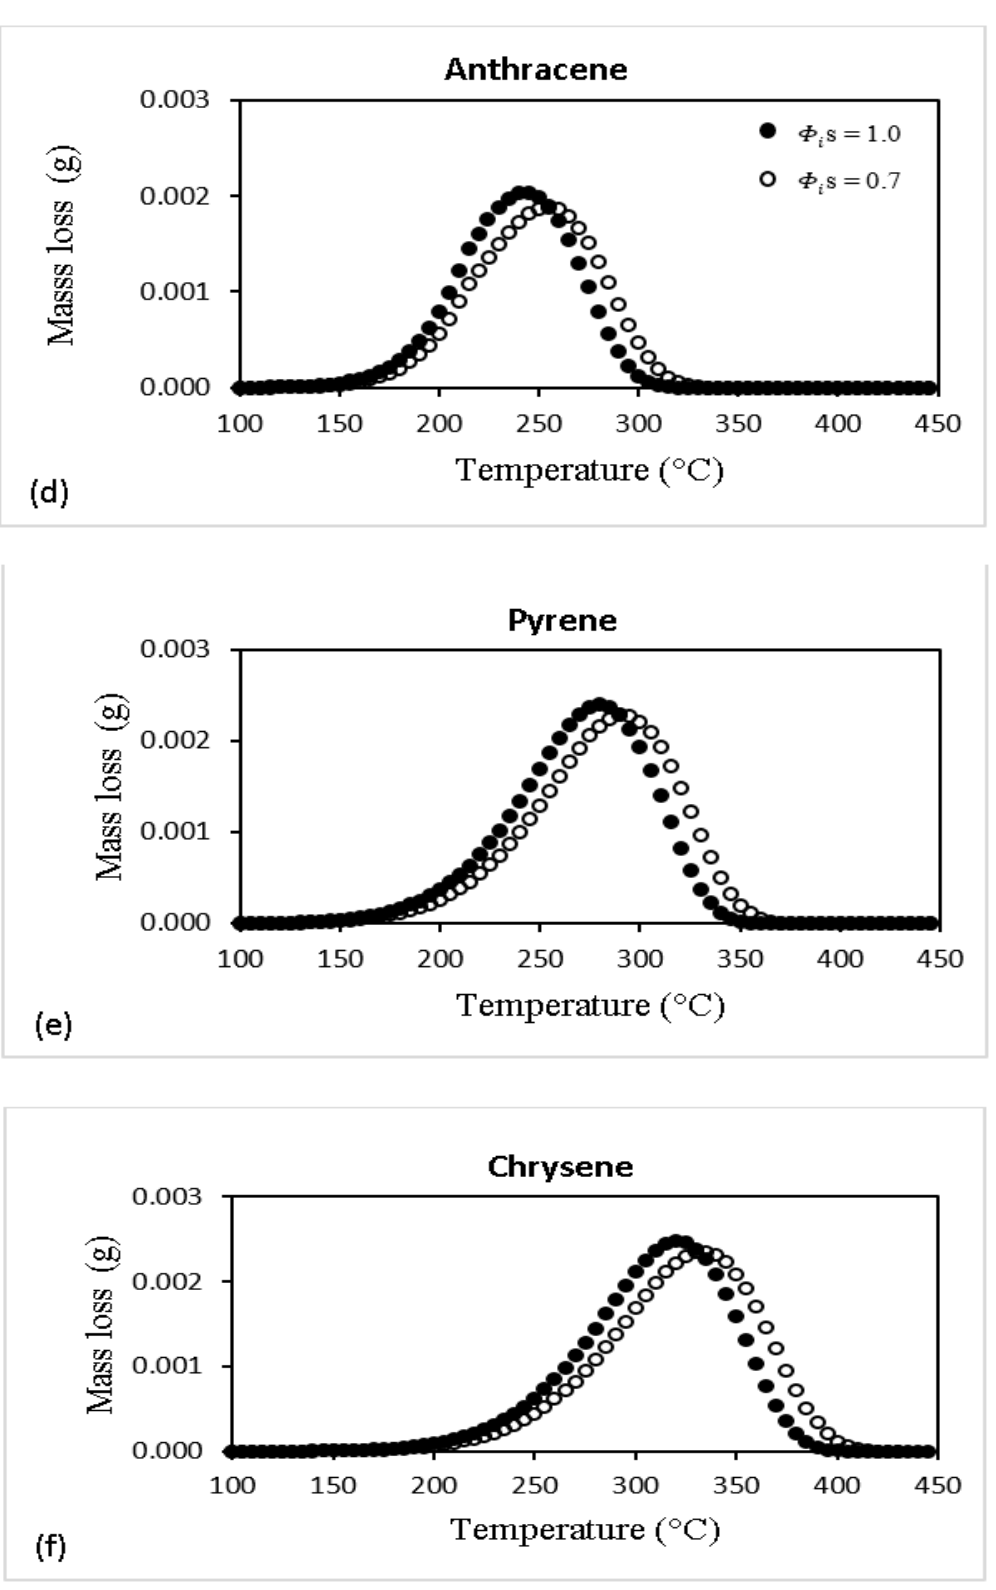
Figure 11. Estimated mass loss of anthracene, pyrene and chrysene versus temperature for different heating rates at carrier gas flow rate of 2300 cm 3 /min and φ i s = 1 ( a – c ) and with different values of ◦ C/h, carrier gas flow rate of 2300 cm 3 /min ( d – f φ i s parameters at a heating rate of 50